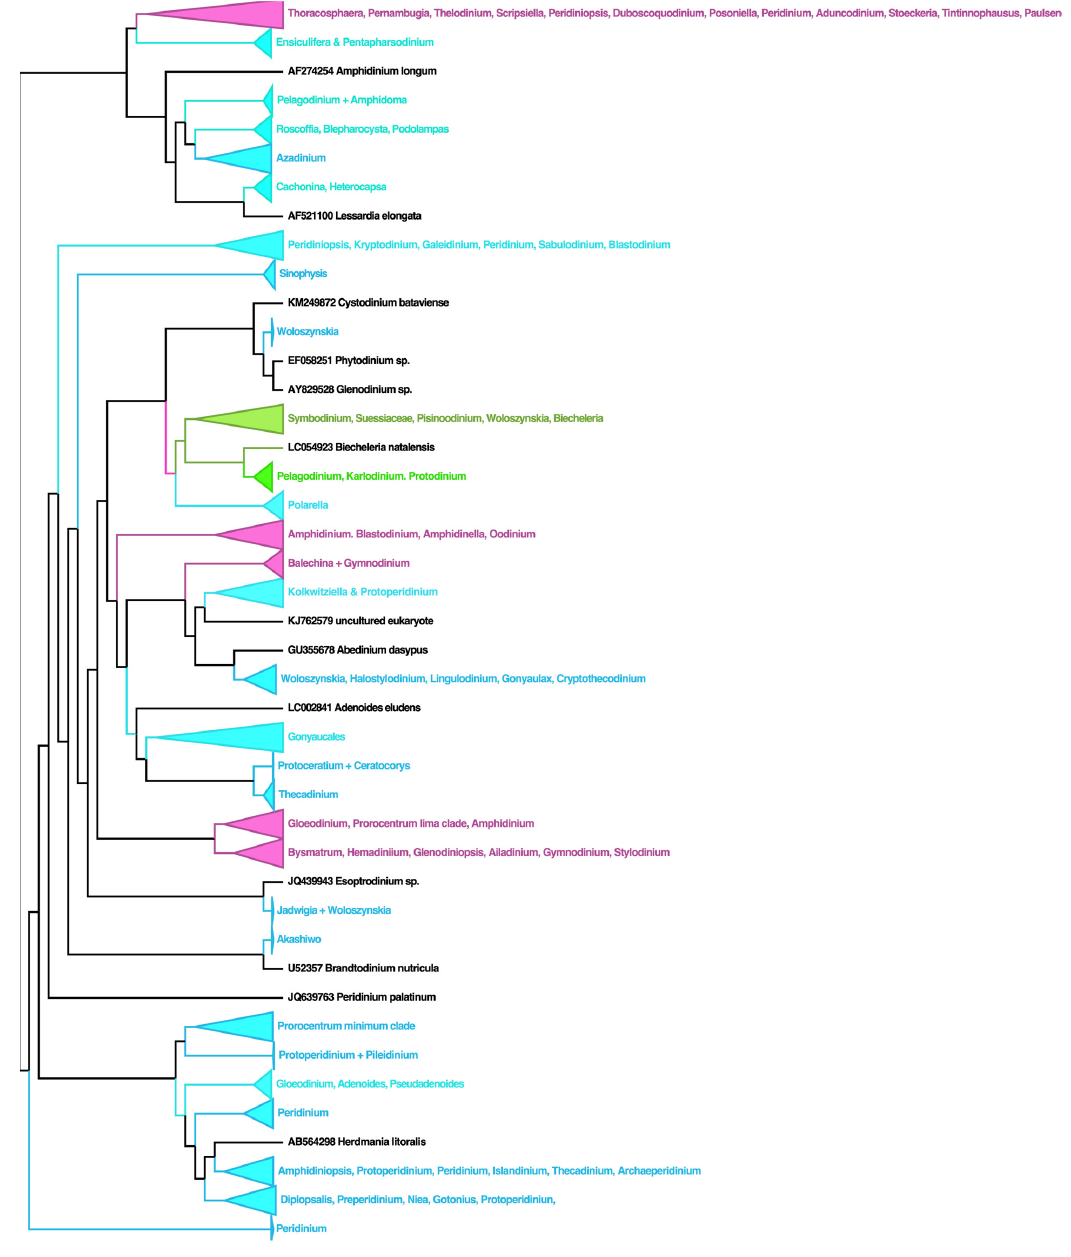
Figure 13. Enlarged view of clade 3A ii .